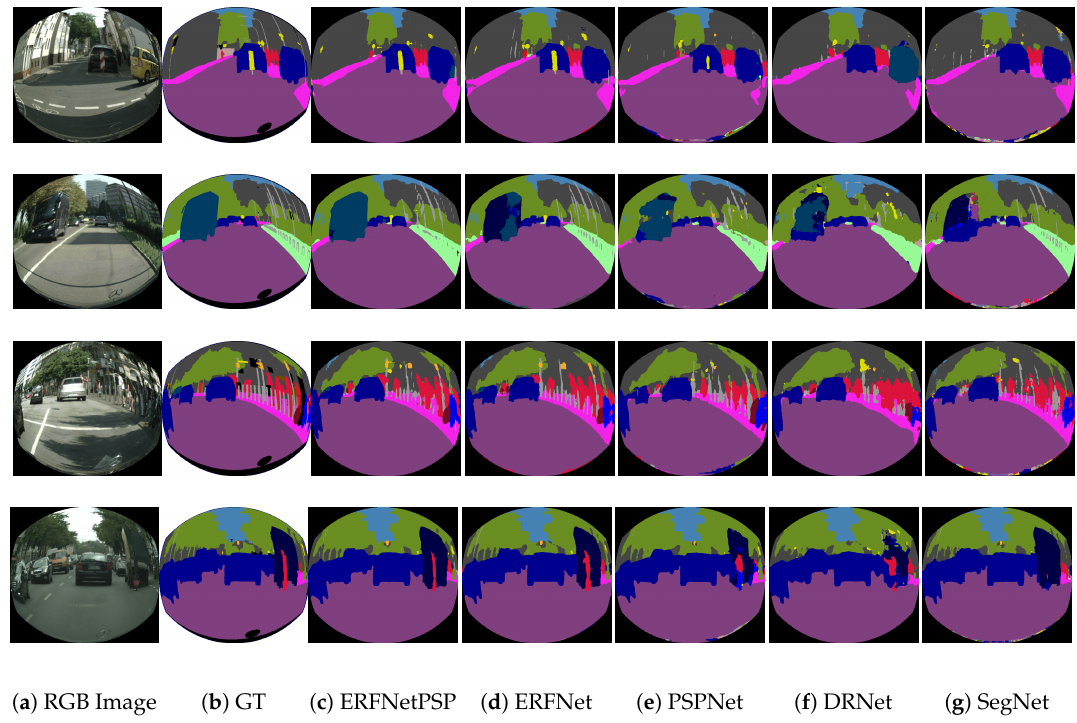
Figure 8. Qualitative results for different tested network models.